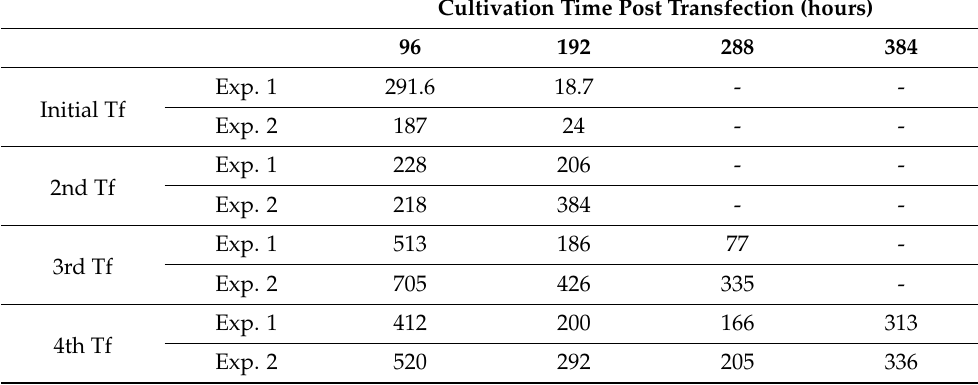
Table 4. BMP2 production yields (ng/10 6 cells) after RTT of HEK sus cells on micro-scale us- ing